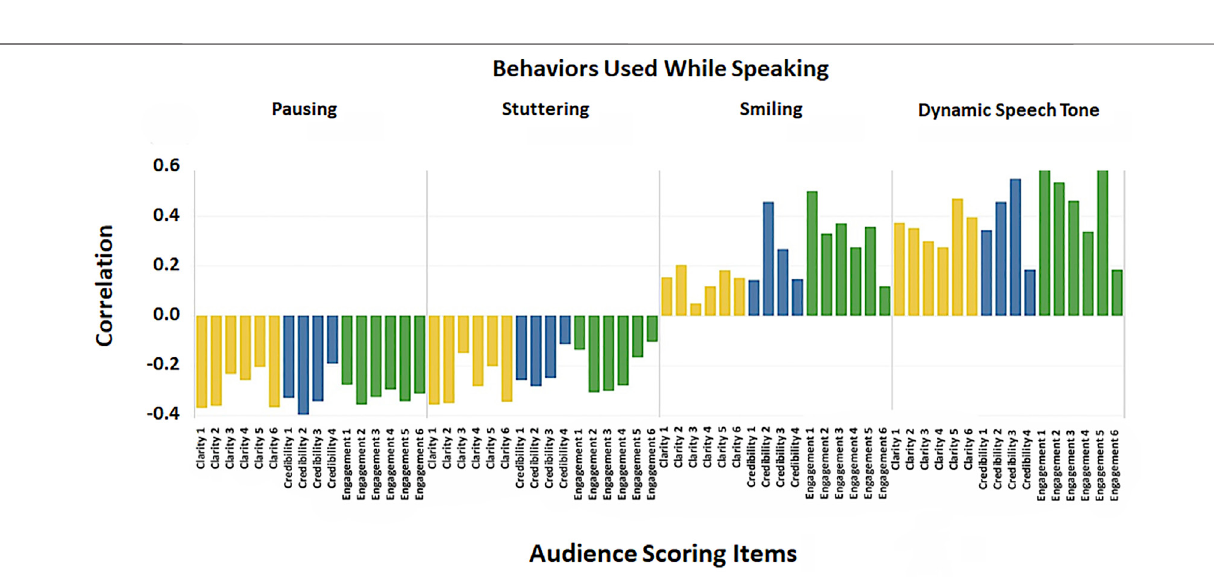
examining the number of trainees using jargon at low vs. high